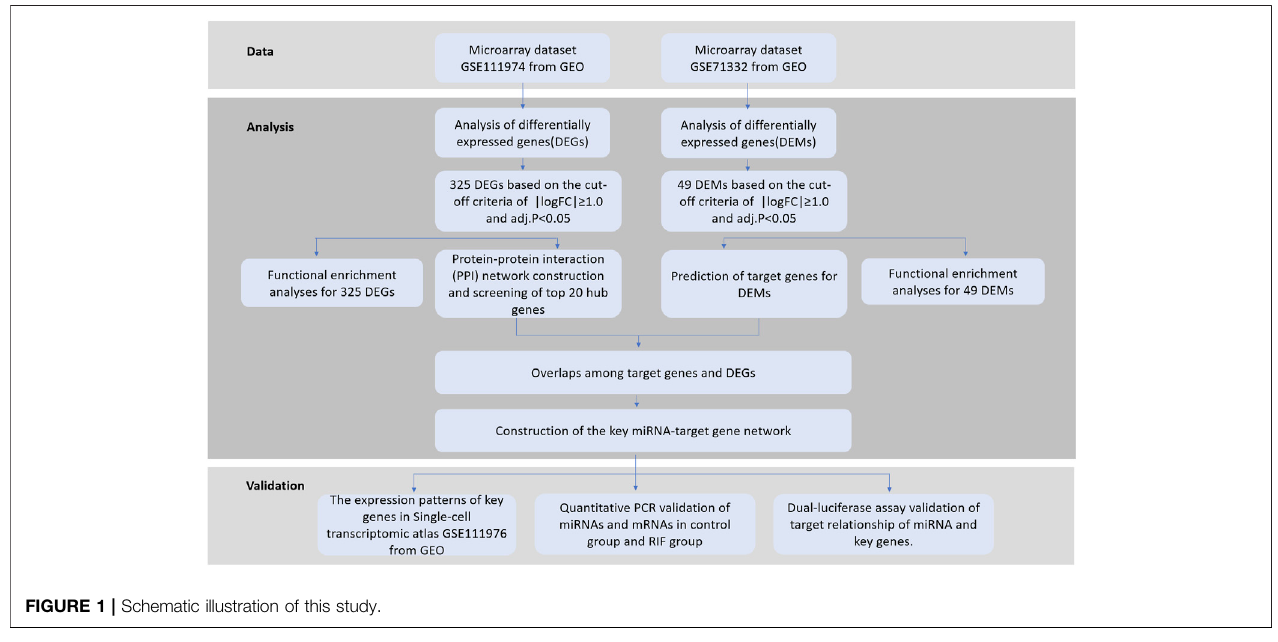
FIGURE 1 | Schematic illustration of this study.